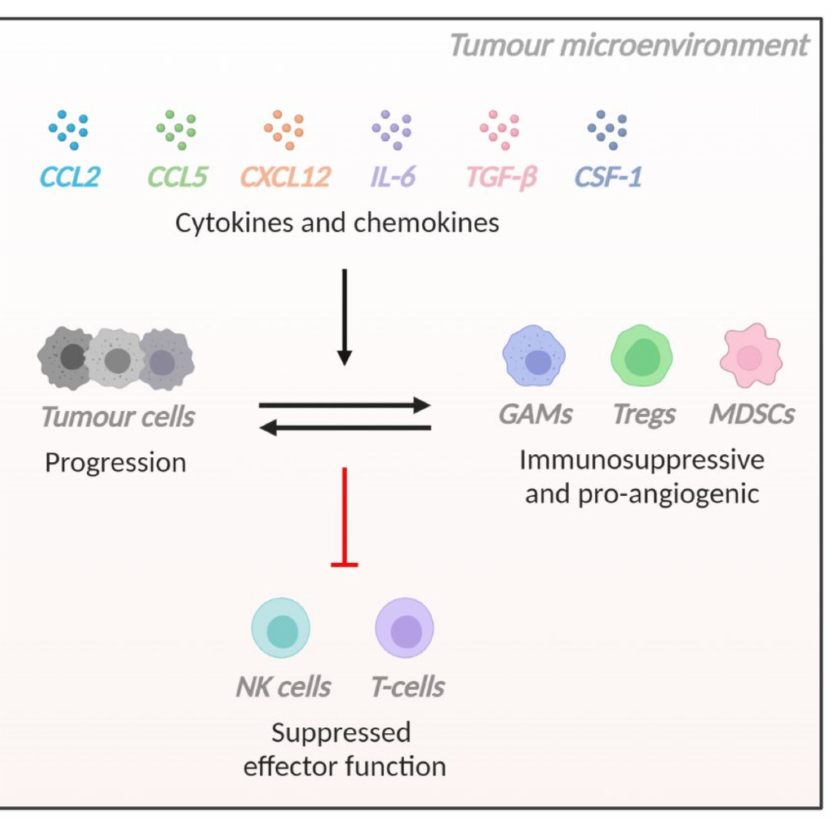
Figure 1. Schematic representation of the crosstalk between tumour and immune cells facilitated by key cytokines and chemokines within the glioblastoma microenvironment. Table 1. Key cytokines, chemokines and their respective receptors in glioblastoma.